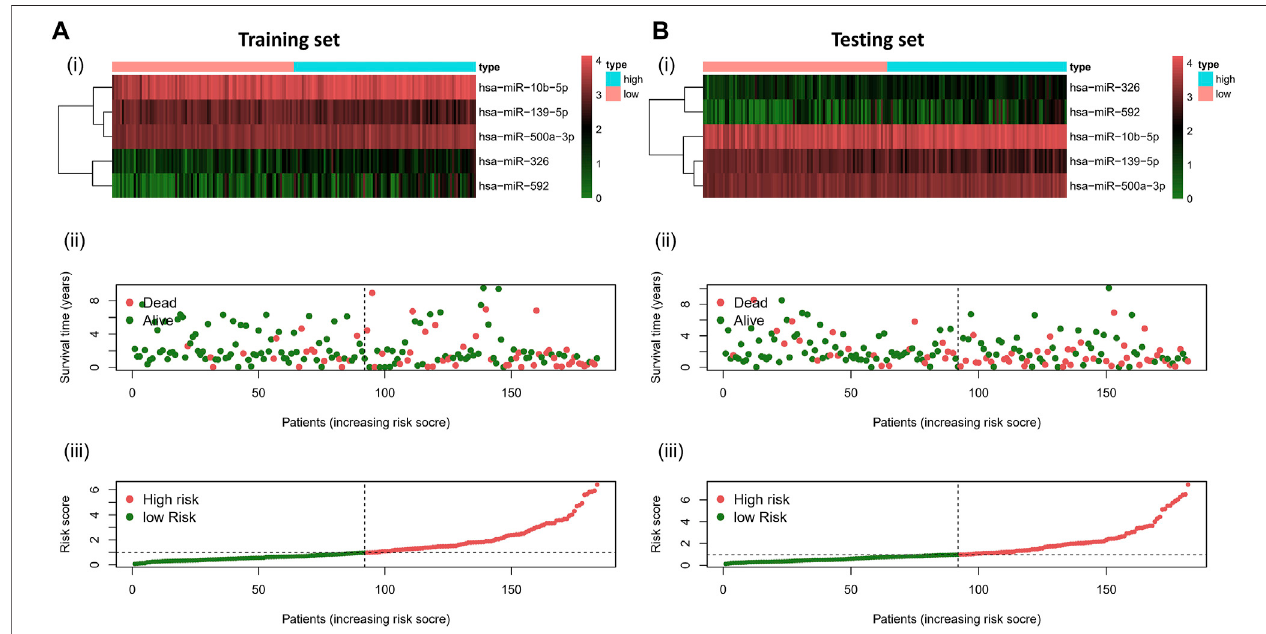
FIGURE 4 | Risk distribution of all patients. (A) Training sets [(A), i] Heatmap of different risk groups in 5-speci fi c necroptosis-related miRNAs. [(A), ii] Risk score scatter plot. [(A), iii] Risk score curve plot. (B) Testing sets [(B), i] Heatmap of different risk group in 5-speci fi c necroptosis-related miRNAs. [(B), ii] Risk score scatter plot. [(A), iii] Risk score curve plot. Patients are categorized into low-risk (green) and high-risk (red)